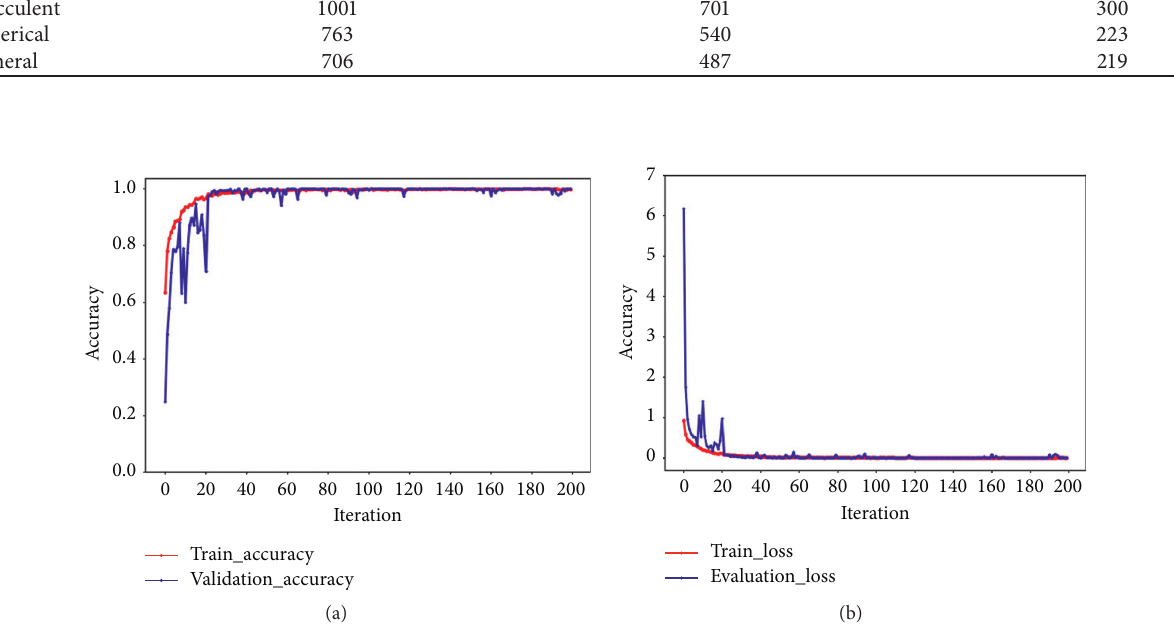
Figure 6: Accuracy and loss curve of training samples and test samples of Attention-CNN. (a) Accuracy curve; (b) loss curve.